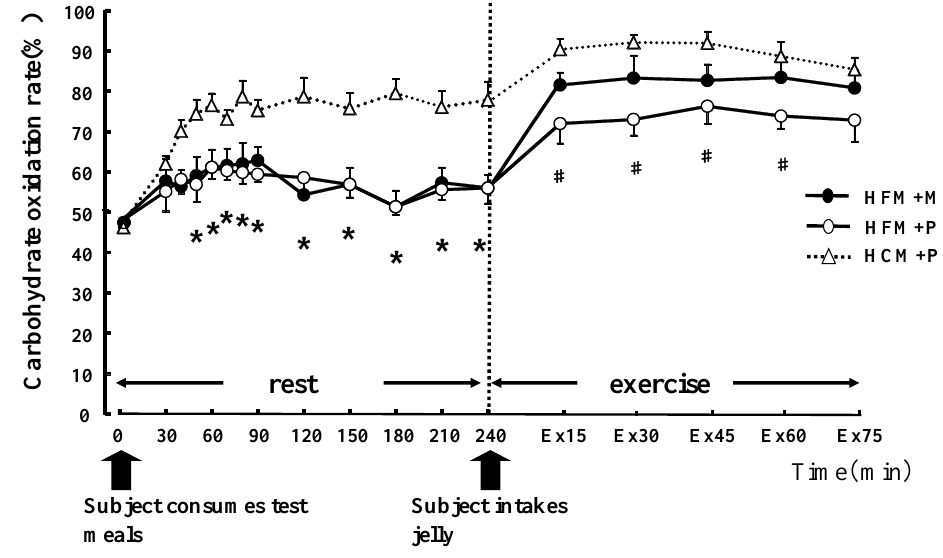
Figure 3. Carbohydrate oxidation rates (%) for 240 min at rest and for 75 min during exercise. * indicates when high-fat meal with maltodextrin (HFM + M) and high-fat meal with placebo (HFM + P) values were significantly lower than high-carbohydrate meal and placebo (HCM + P) values ( p < 0.05). # indicates when HFM + P was significantly lower than HCM + P ( p < 0.05). Data are shown as mean ± S.E.